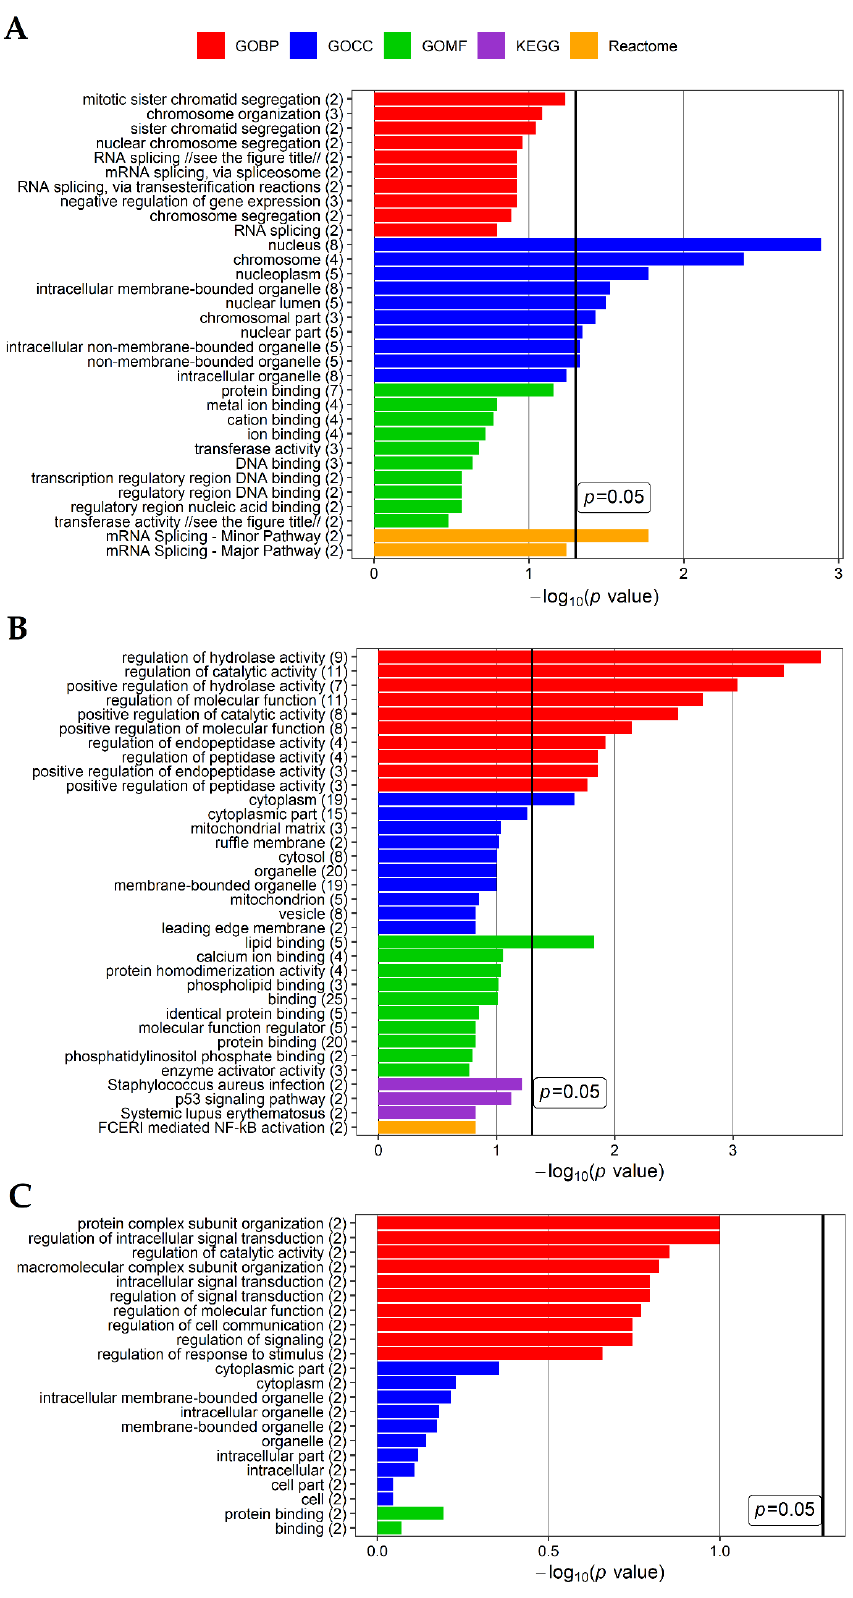
Figure 5. Results of functional analysis performed using DAVID website tool for the sets of ( A ) 21 unique genes for LEAD vs. AAA comparison, ( B ) 58 unique genes for LEAD vs. CVD comparison and ( C ) 10 unique genes for AAA vs. CVD comparison. Similar to Figure 2, up to ten of the most enriched terms of Gene Ontology Biological Processing (GOBP), Gene Ontology Cellular